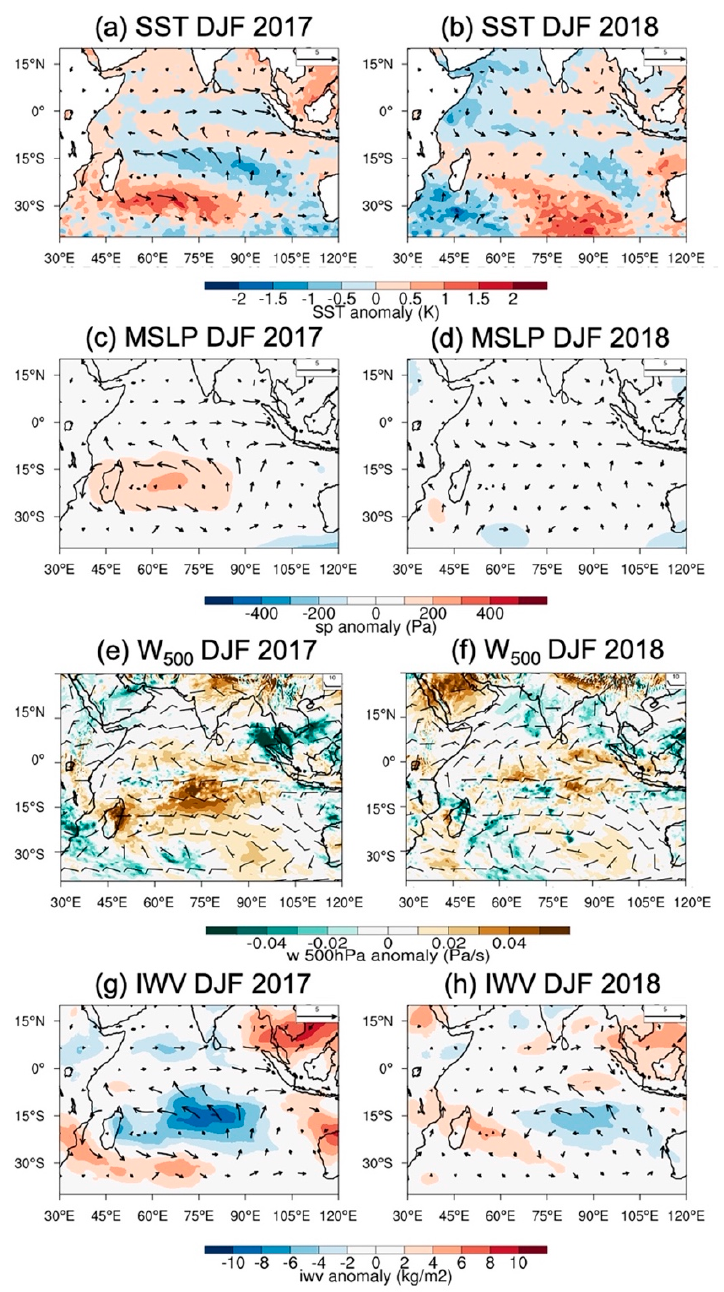
Figure 7. ( a , b ) Sea Surface Temperature (SST), Mean Sea Level Pressure (MSLP), Vertical velocity at 500 hPa (W) and Integrated Water Vapour (IWV) anomalies in summer (DJF) 2017 ( left panel ) and 2018 ( right panel ), computed from ERA5 reanalysis data over the period 1990–2020.